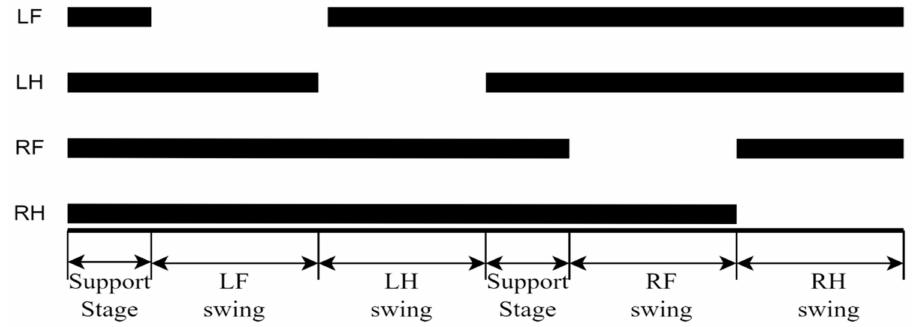
Figure 6. Sequence diagram of crawling gait.